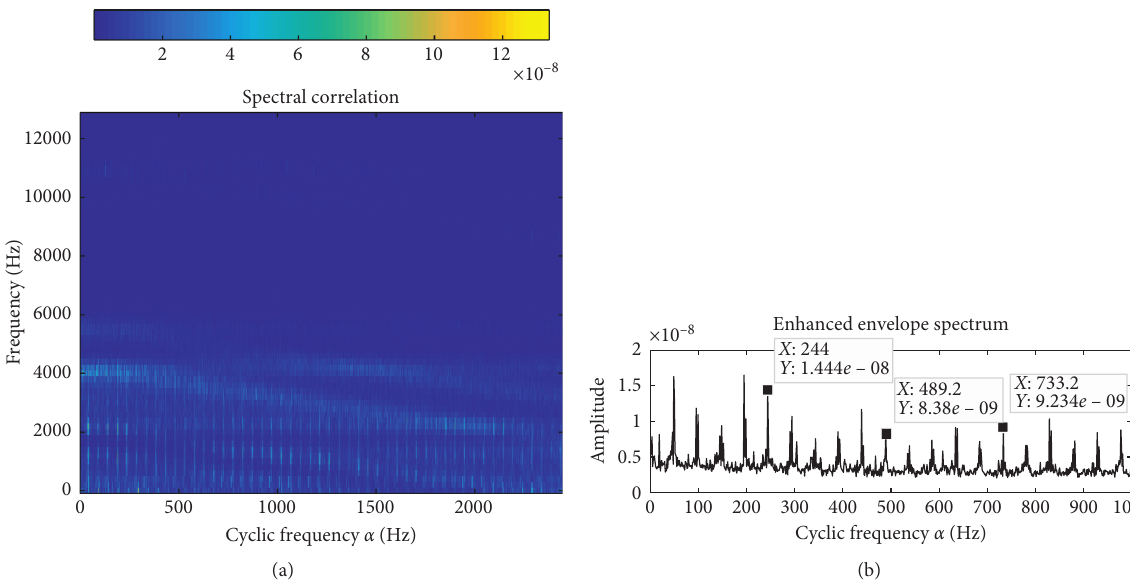
Figure 9: FSC image and EES of the reconstructed early weak fault signal: (a) FSC image of the reconstructed early weak fault signal by using the learned atoms as shown in Figure 8; (b) EES of the reconstructed early weak fault signal by using the obtained FSC image as shown in Figure